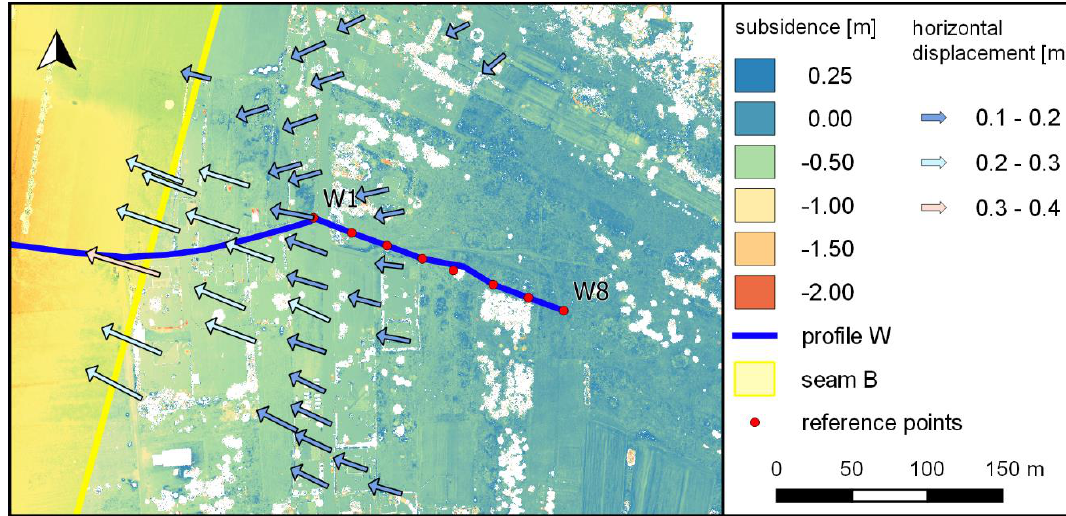
Figure 4. Jaworzno site displacements determined using UAV photogrammetry for 04.2016 – 02.2020.